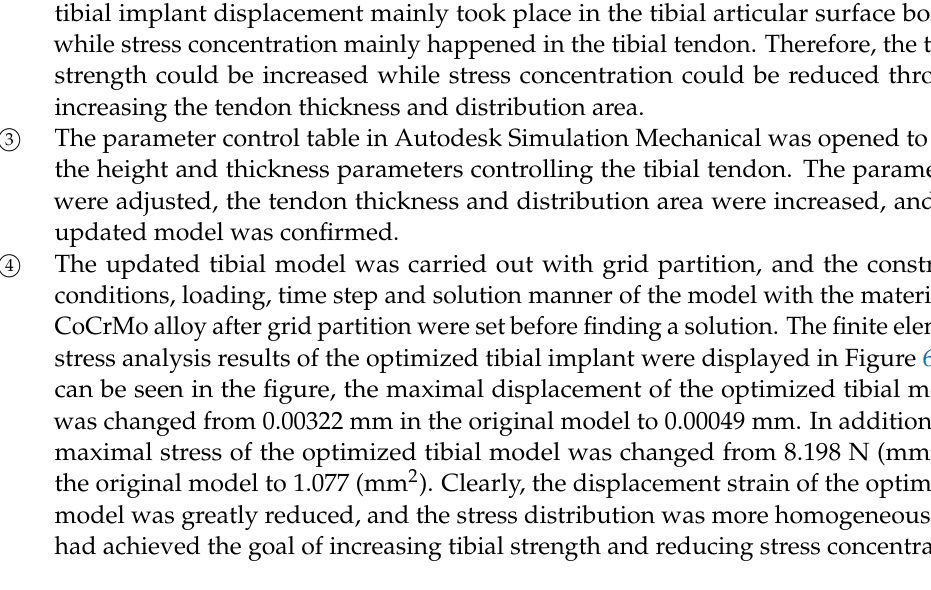
Figure 5. Results of finite element analysis of a tibial implant: ( a ) Displacement distribution; and ( b ) Stress distribution.